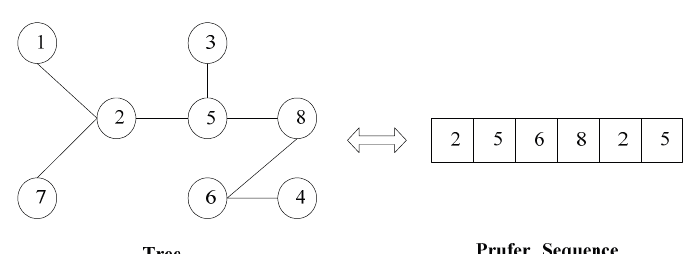
Figure 2. A tree and its Prufer